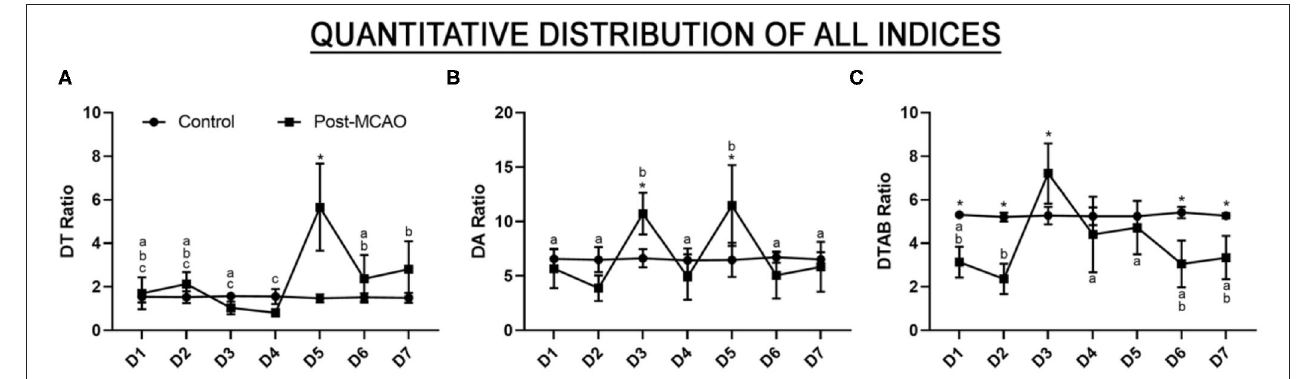
FIGURE 4 | Quantitative EEG predictor index and the results of the monitoring of the evolution of the stroke in the subacute phase. (A) Quantitative electroencephalographic data on the delta/theta ratio; (B) The delta/alpha ratio; (C) The delta + theta/alpha + beta ratio. The data are expressed as the means ± SD